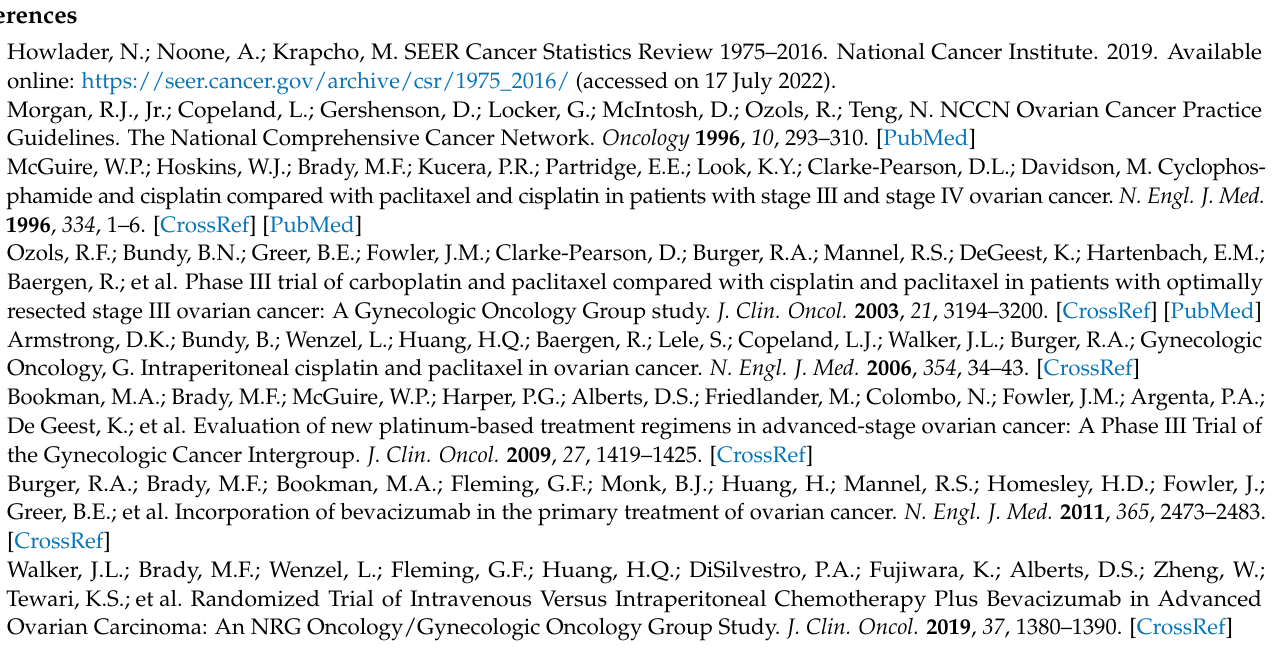
cytoreduction; Supplementary Figure S4: TCGA validation of prediction models of response in complete cytoreduction; Supplementary Figure S5: Validation of optimal cytoreduction prediction models with machine learning analytical platform; Supplementary Figure S6: Validation of complete cytoreduction prediction models with machine learning analytical